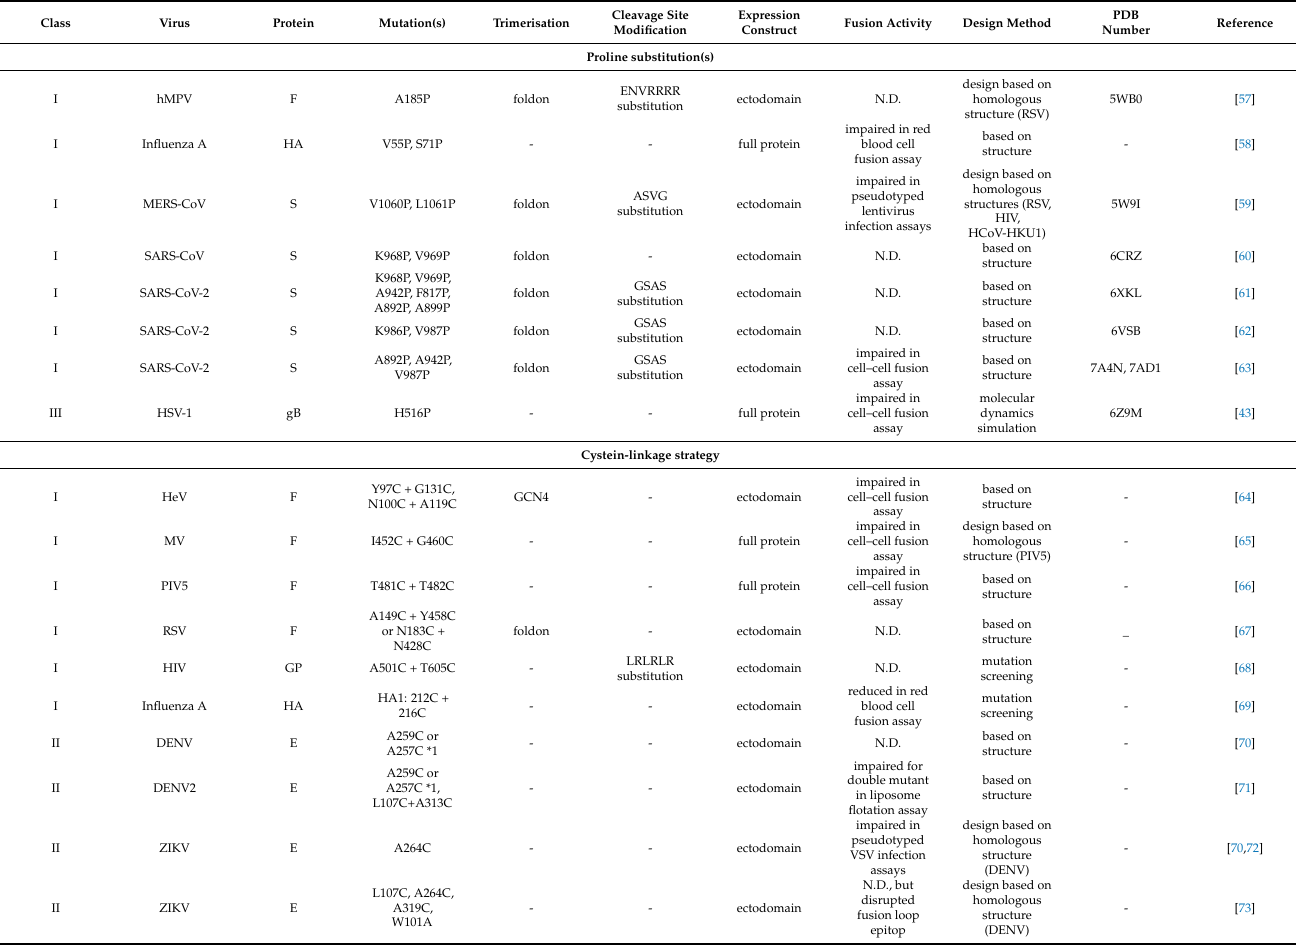
Table 1. Overview of viral membrane fusion proteins stabilised in pre-fusion conformation, grouped by stabilisation